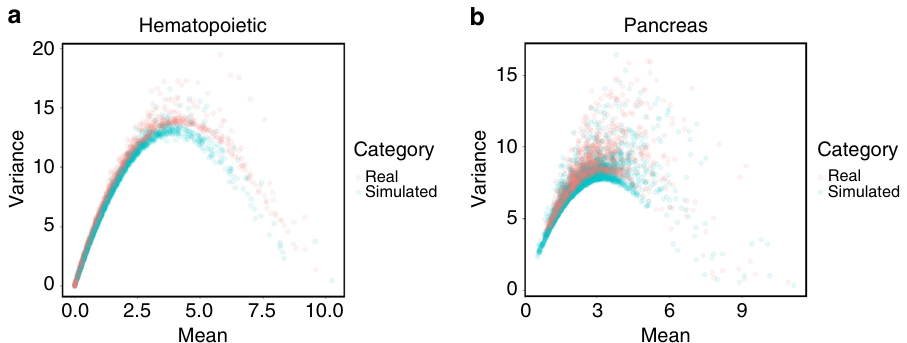
Fig. 5 BUSseq recapitulates the mean-variance trends of the real data. Scatter plot of the variance versus the mean of each gene for a the hematopoietic study and b the pancreas study. Red points are the observed values from real data; blue points correspond to the values of the data simulated according to the estimates of BUSseq for the real